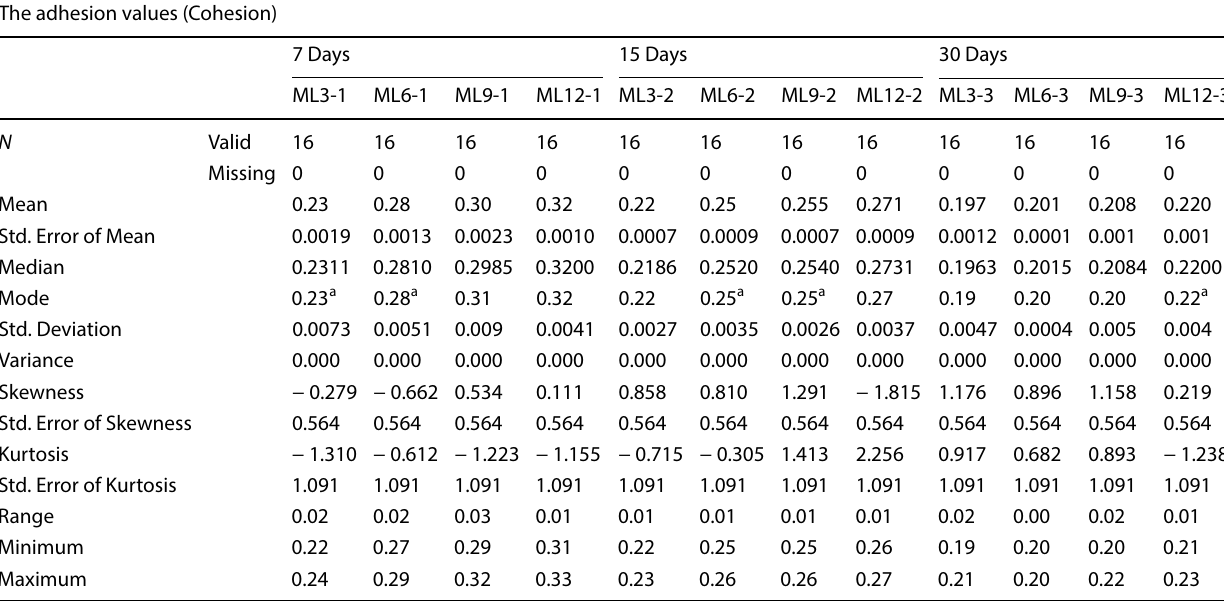
a Multiple modes exist. The smallest value is